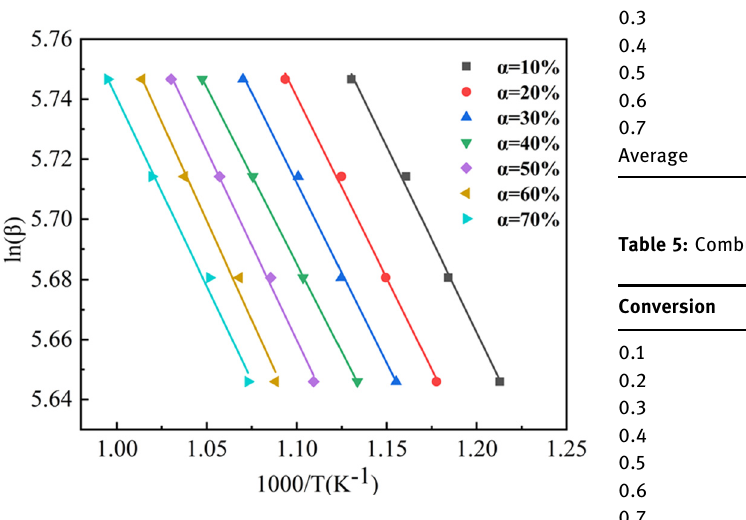
Figure 11: FWO method plots of sample K4 in di ff erent conversion degrees.